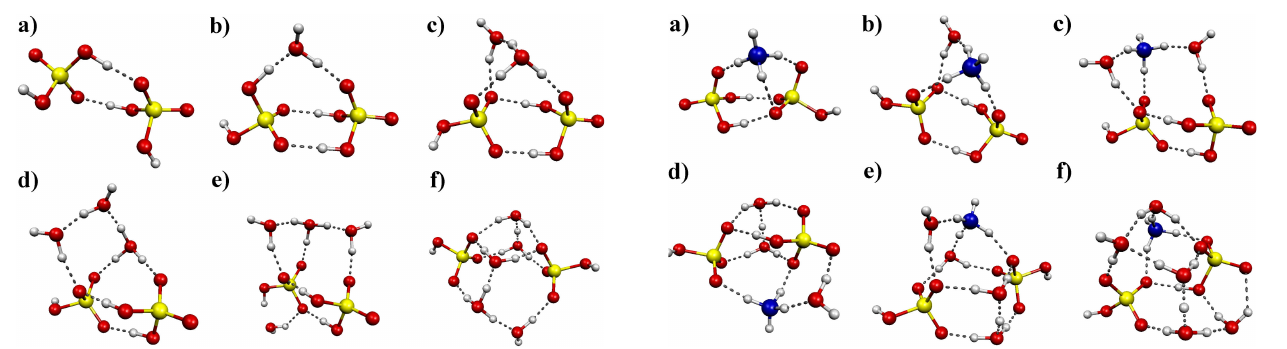
Fig. 4. The most stable structures with respect to the formation free energy 1G (at T = 298 . 15K and P = 1atm) for clusters consisting of two sulfuric acids and 0–5 water molecules: (a) ( H 2 SO 4 ) 2 , (b) ( H 2 SO 4 ) 2 · H 2 O, (c) ( H 2 SO 4 ) 2 · ( H 2 O ) 2 , (d) ( H 2 SO 4 ) 2 · ( H 2 O ) 3 , (e) ( H 2 SO 4 ) 2 · ( H 2 O ) 4 , (f) ( H 2 SO 4 ) 2 · ( H 2 O ) 5 .